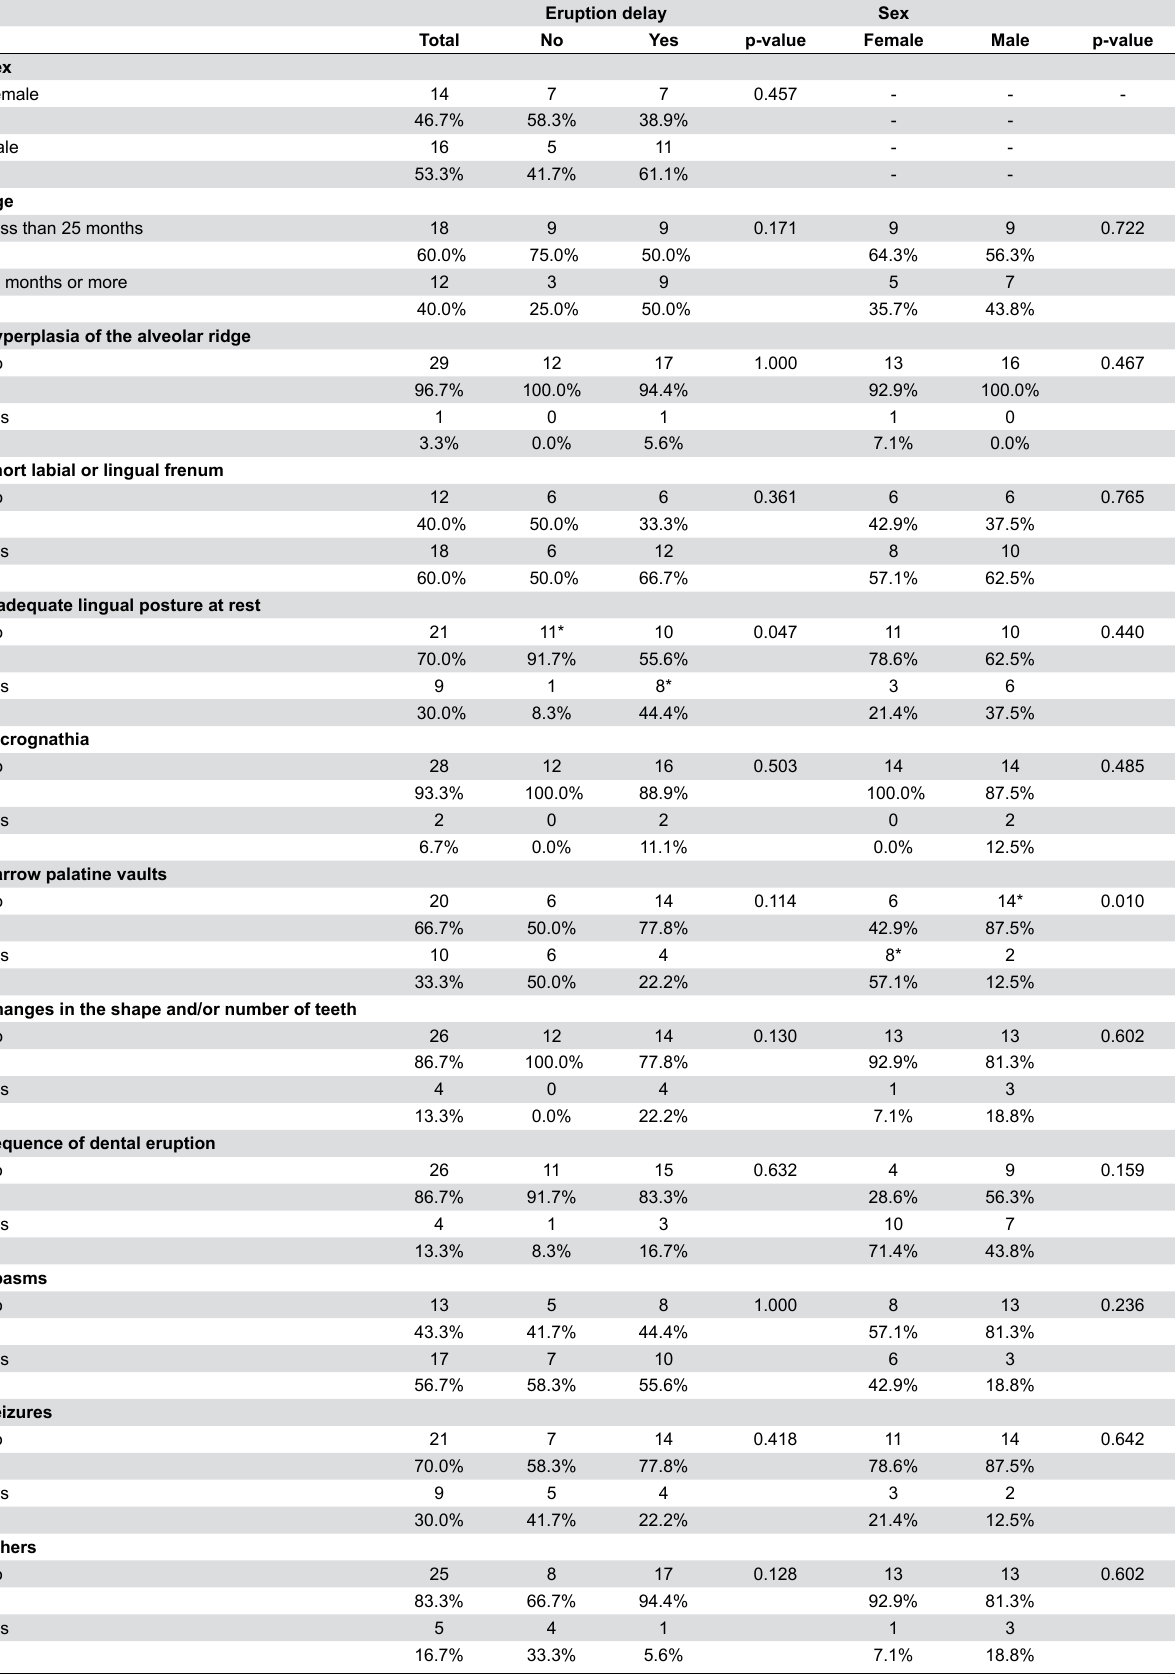
Table 1- Evaluation of clinical characteristics and delays in the first eruptions of ZIKV children